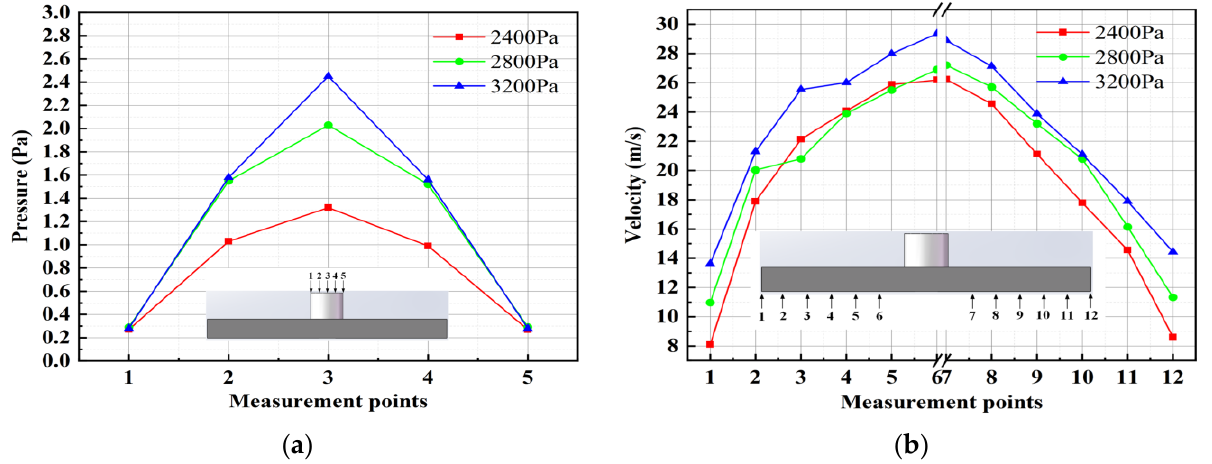
Figure 6. Simulation results of flow field characteristics at different negative pressures: ( a ) simulated pressure values; ( b ) simulation velocity values.